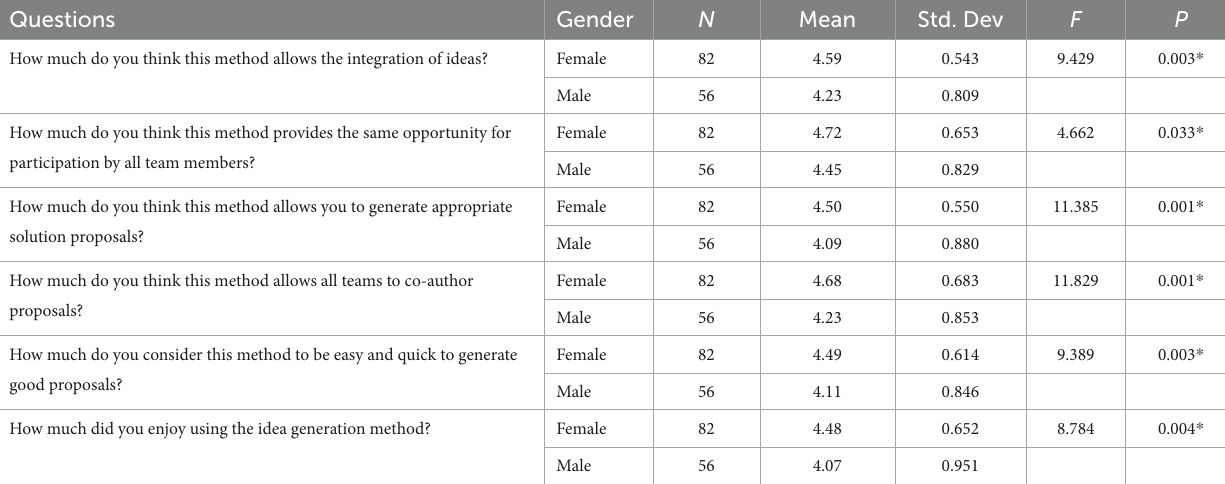
TABLE 6 Descriptive statistical and ANOVA for GENDER.